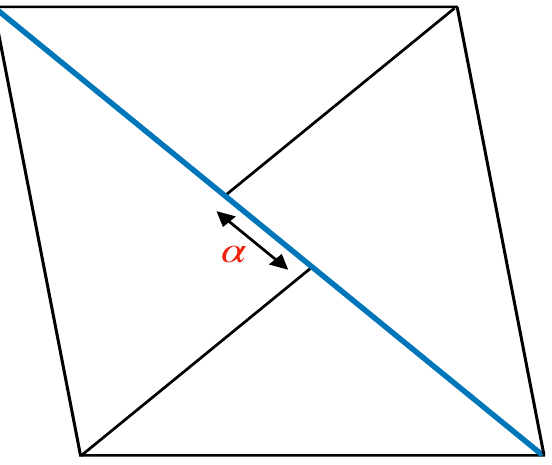
Figure 2 . Penrose diagram of the shockwave geometry (2.18) created by a highly boosted particle that travels along the past horizon v = 0 (the blue line). There is a discontinuity in the coordinate ~ u by an amount (cid:11) which brings the left and right static patch into causal contact with each